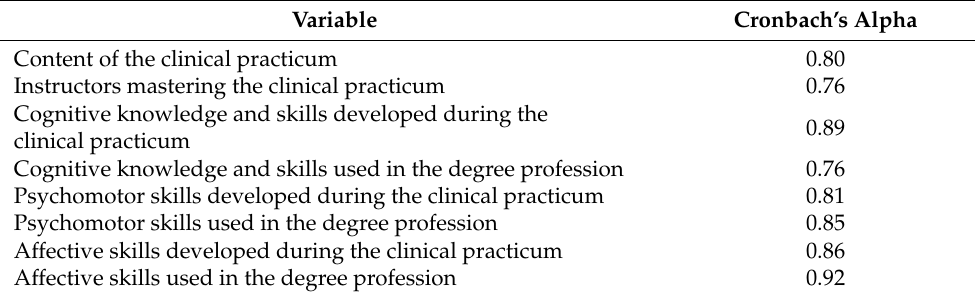
Table 4. Internal consistency of the questionnaire domain